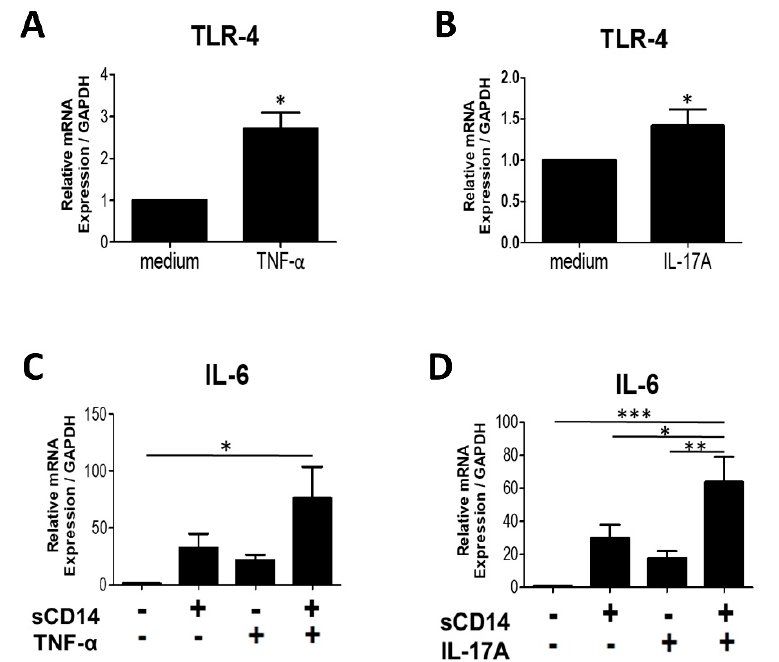
Figure 5. Addition of TNF- α or IL-17A augments the response of RA-FLS to sCD14. ( A , B ) RA-FLS were cultured with or without TNF- α (10 ng / mL) ( A ) or IL-17A (10 ng / mL) ( B ) for 3 h. Thereafter, relative expression levels of TLR-4 mRNA were measured by real-time PCR and normalized to GAPDH. Data are shown as means ± SEM in five ( A ) and nine ( B ) RA-FLS. Statistical significance was analyzed by unpaired t -test (* p < 0.05). ( C , D ) RA-FLS were cultured with sCD14 (500 ng / mL), TNF- α (10 ng / mL) or sCD14 + TNF- α ( C ), or sCD14 (500 ng / mL), IL-17A (10 ng / mL) or sCD14 + IL-17A ( D ) for 3 h. After culture, relative expression levels of IL-6 mRNA were measured by real-time PCR and normalized to GAPDH. Data are shown as means ± SEM in five ( C ) and nine ( D ) RA-FLS. Statistical significance was analyzed by Tukey’s Multiple Comparison Test (* p < 0.05, ** p < 0.01, and *** p <